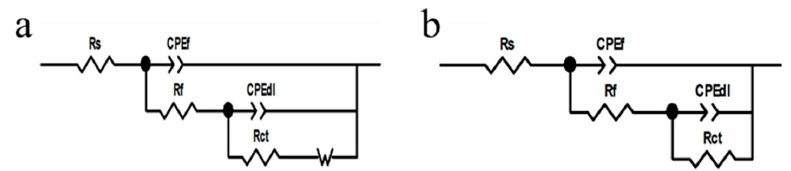
Figure 8. Equivalent circuits used for fitting impedance data: ( a ) bare copper electrode and copper electrode with 1-dodecanethiol SAM; ( b ) H 3 PO 4 -treated copper electrode with 1-dodecanethiol SAM.